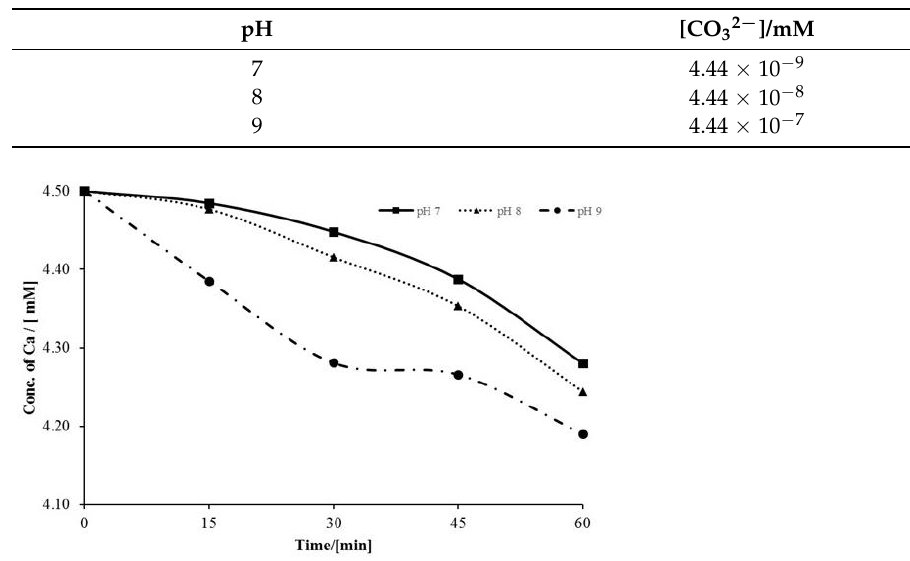
Figure 1. Effect of pH on calcium concentration over time during the ultrasonication process.